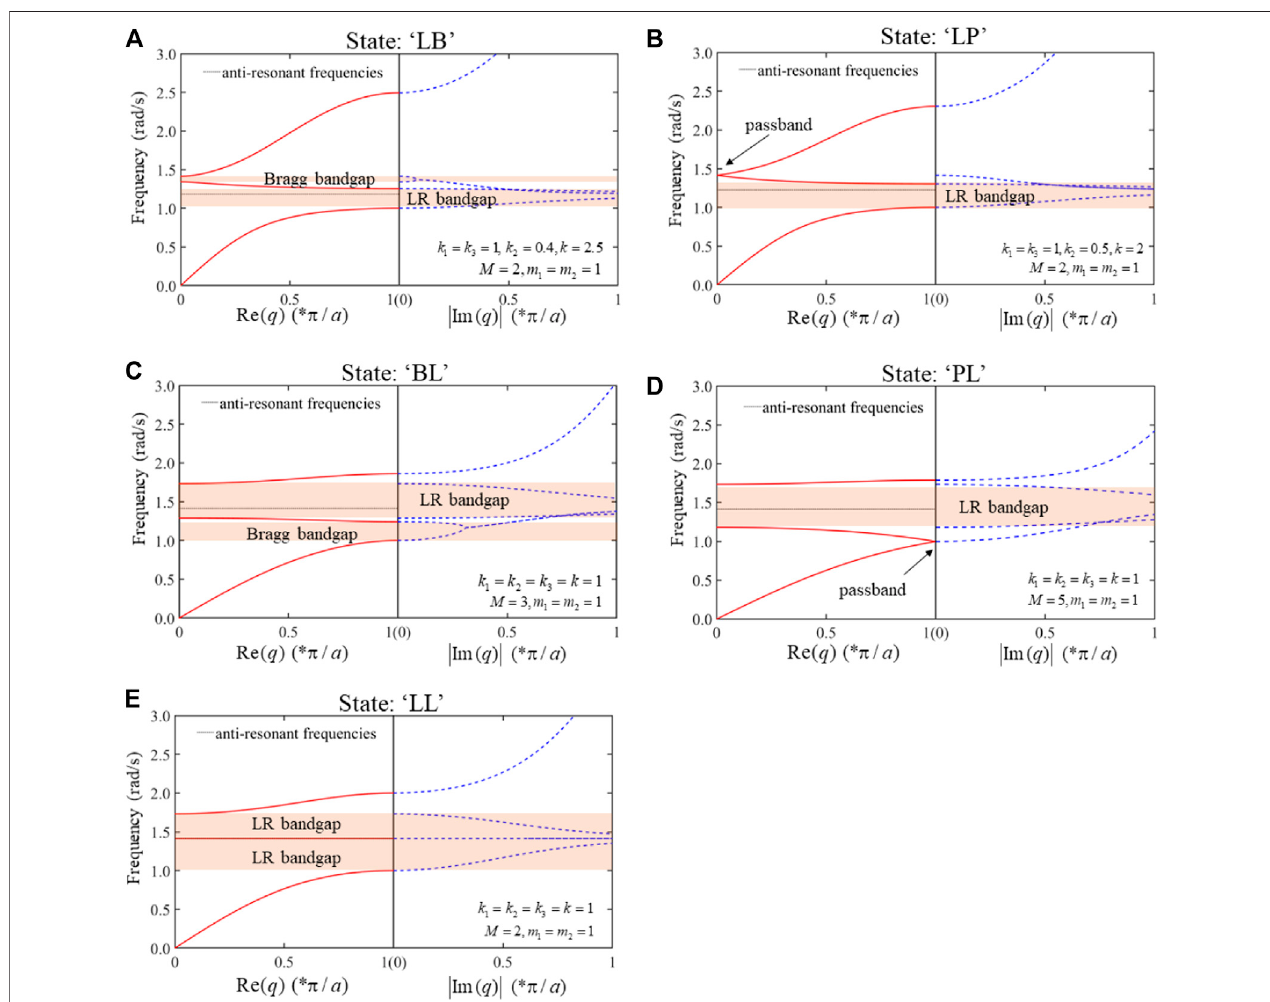
FIGURE 6 | Different bandgap states when there is only one anti-resonant frequency in the mass-coupled monatomic/triatomic chain system. (A) State “ LB ” : the fi rst bandgap is LR bandgap and second one is Bragg bandgap. (B) State “ LP ” : the second Bragg bandgap disappears. (C) State “ BL ” : the fi rst bandgap is Bragg bandgap and second one is LR bandgap. (D) State “ PL ” : the fi rst Bragg bandgap has vanished and only the LR bandgap is left. (E) State “ LL ” : the anti-resonant frequency line coincides with a curve of passband, which generates an enlarged LR bandgap.